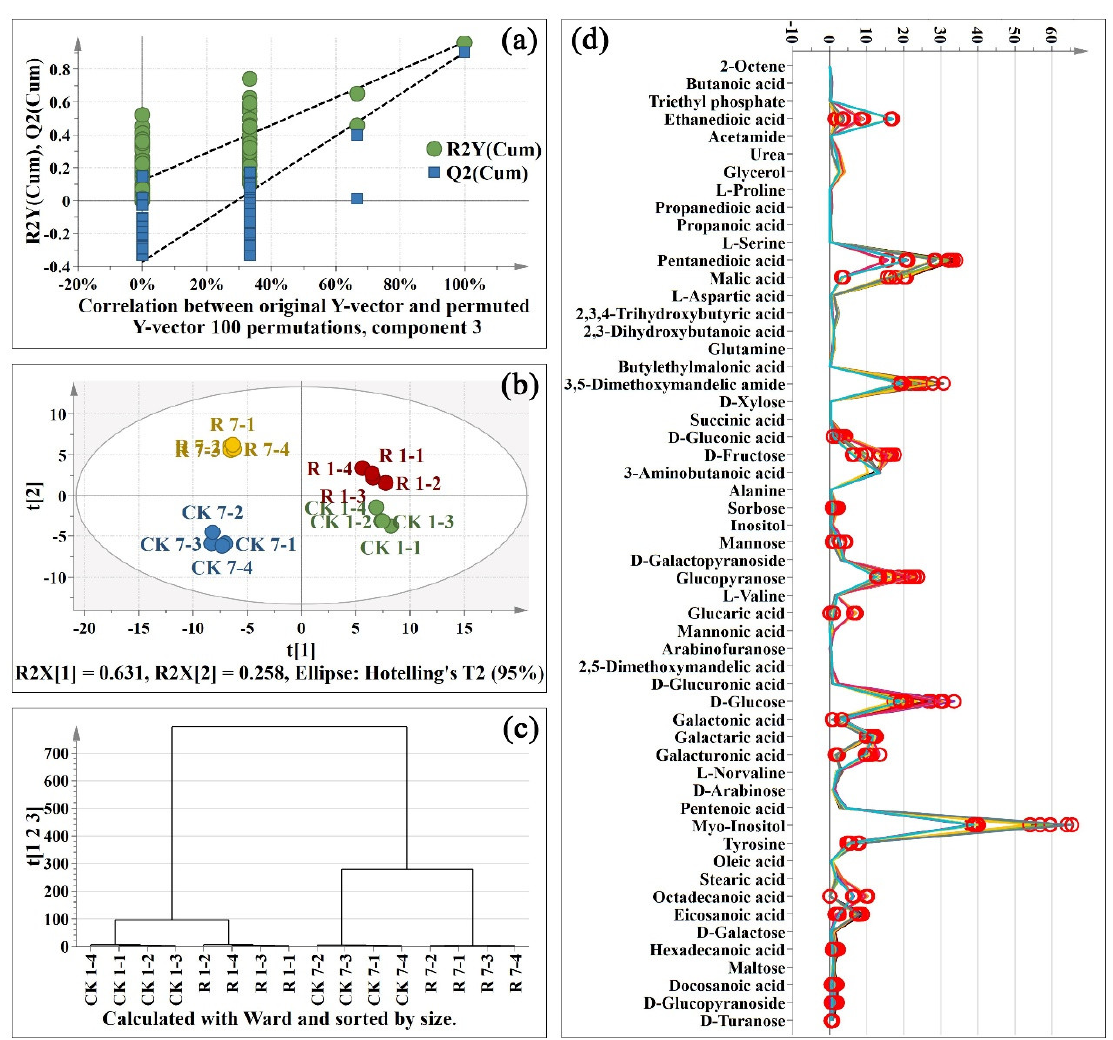
Figure 3. Projection to latent structures discriminant analysis (PLS-DA) of primary metabolites; ( a ): permutations plot of PLS-DA; ( b ): score scatter plot of PLS-DA; ( c ): hierarchical clustering analysis (HCA) plot of PLS-DA; ( d ): spectra plot of PLS-DA. CK: control sample. R: red light. 1-1: one replicate of 1 d sample; 7–2: one replicate of 7 d sample. There are four replicates per sample. The key metabolites in orthogonal projection to latent structures discriminant analysis (OPLS-DA) were marked in red circles in Figure 3d.